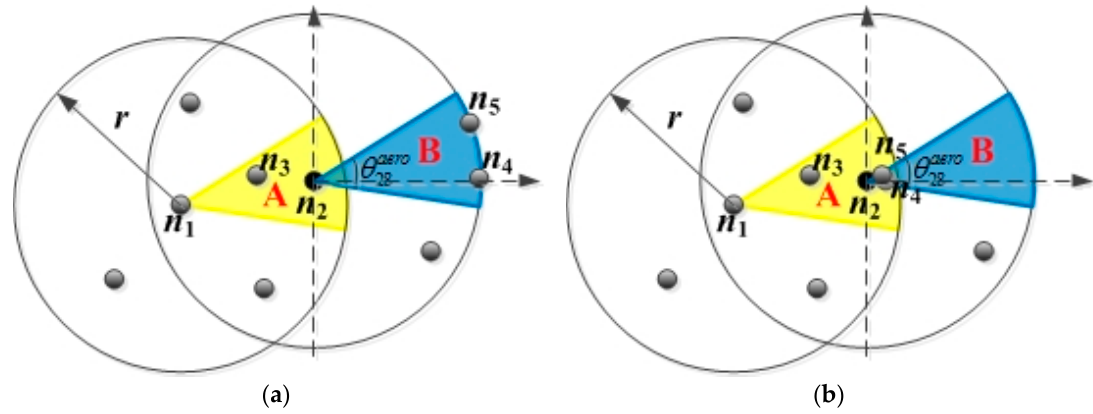
Figure 2. Distribution of the nodes in the CNR of node 2 n : ( a ) Optimal distribution; ( b ) worst distribution.